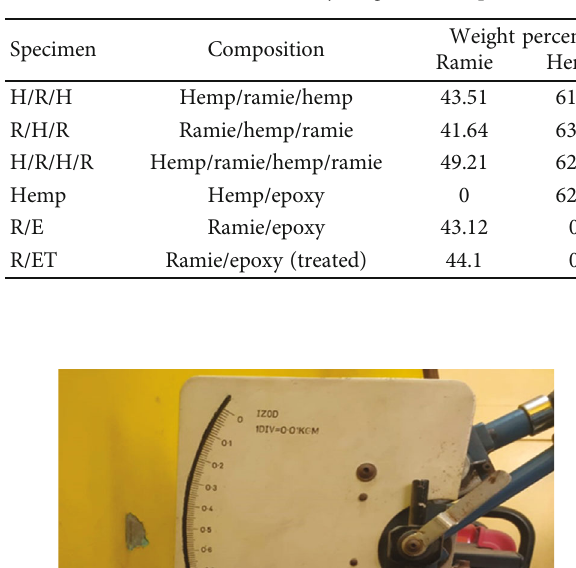
Table 3: Characteristics and layering order of specimens.